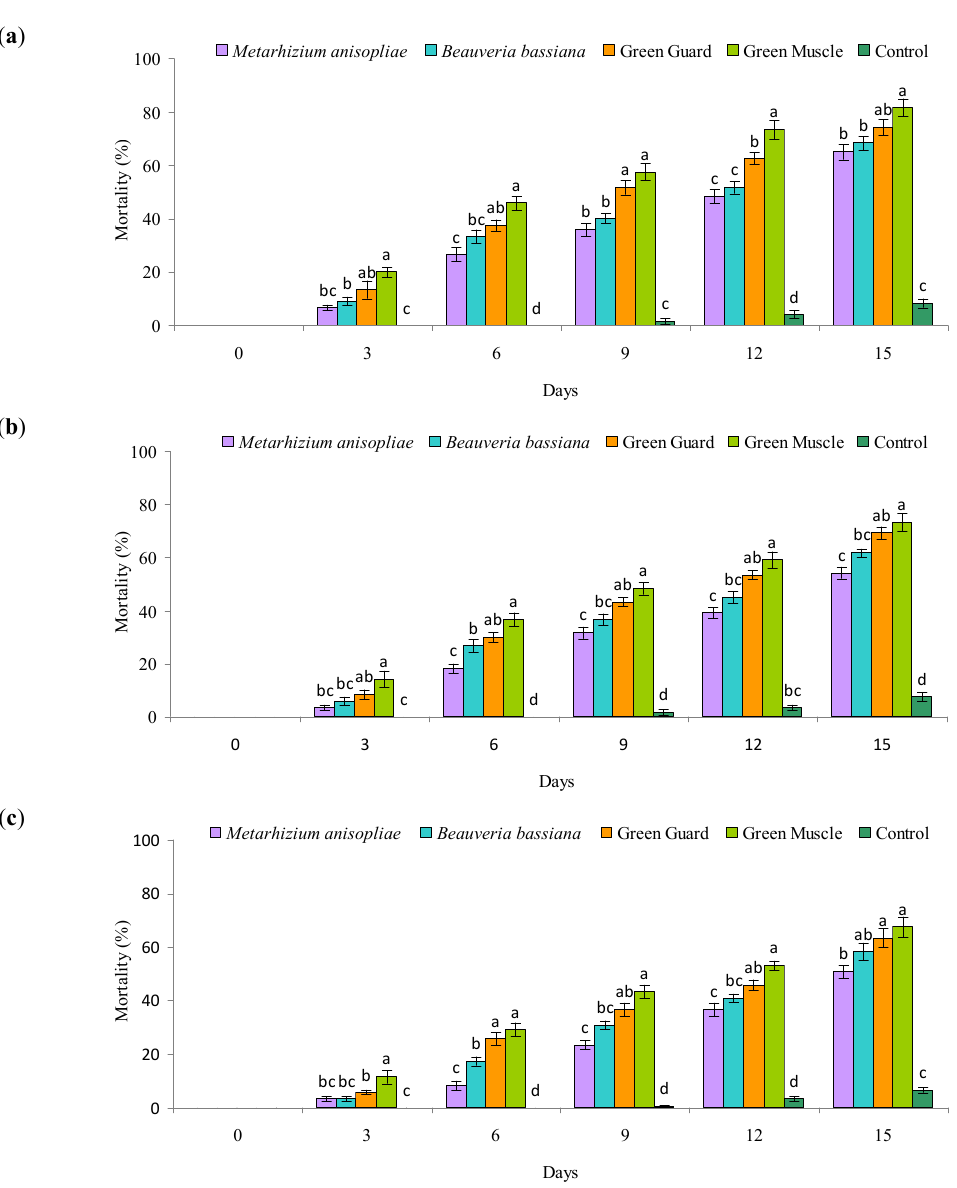
Figure 5. Mean mortality percentages ( ± SE) of ( a ) 3rd-instar, ( b ) 5th-instar, and ( c ) adult S. gregaria inoculated with 1 × 10 9 conidia/mL of Green Muscle, Green Guard, B. bassiana , or M. anisopliae in a greenhouse. Within each subfigure and between the treatments, different letters indicate significant differences (Tukey’s HSD test at p ≤ 0.05).